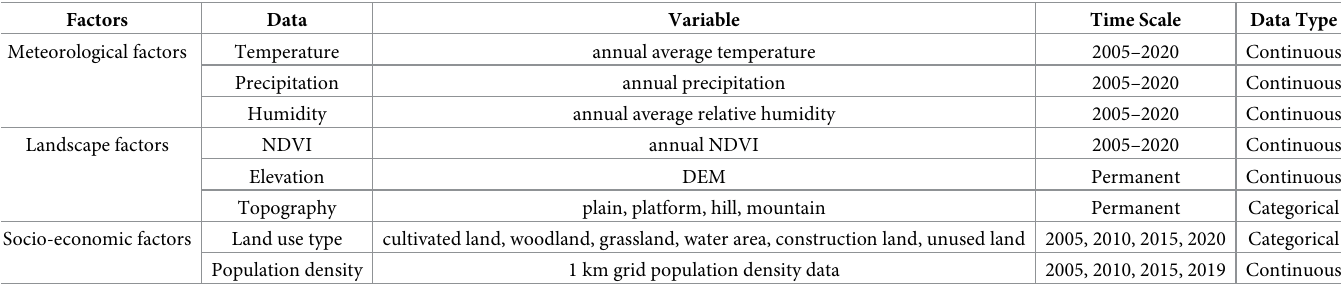
Table 1. Variables used to construct the MaxEnt model in this